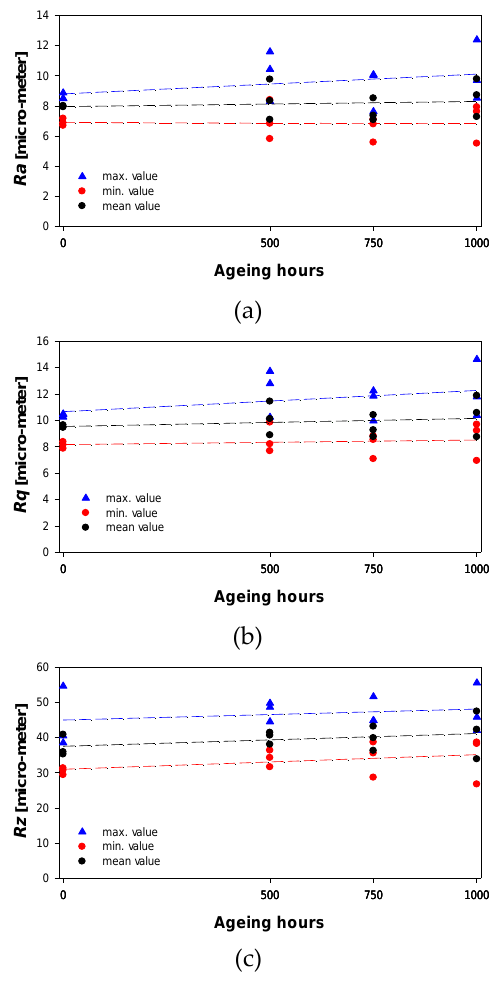
Figure 5. J-line connectors. Surface roughness measurements. Dashed lines are the tendency lines. ( a )